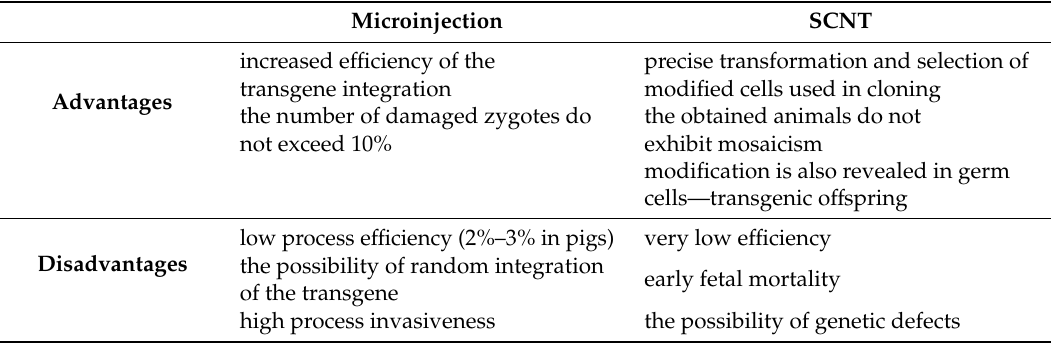
Table 1. Summary of the most important advantages and disadvantages of the methods for obtaining genetically modified